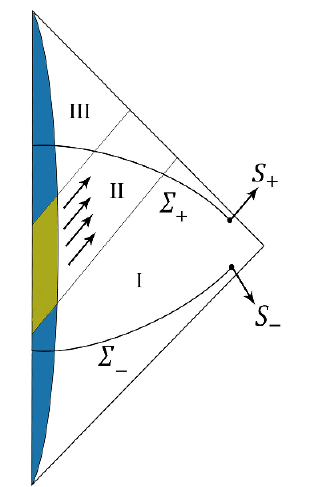
Figure 2 . A distribution of charged matter (colored), which is stationary in far past and far future (regions I,III) and radiating in the region II. The charges are computed at two time slices (cid:6) (cid:0) and (cid:6) + before and after the radiation phase, and are given by surface integrals over S (cid:6) of radius R where S (cid:6) = @ (cid:6) (cid:6) . These two surfaces are connected by a timelike hypersurface (cid:6) B of constant radius (not drawn). Note that both S (cid:6) reside in region I as R ! 1